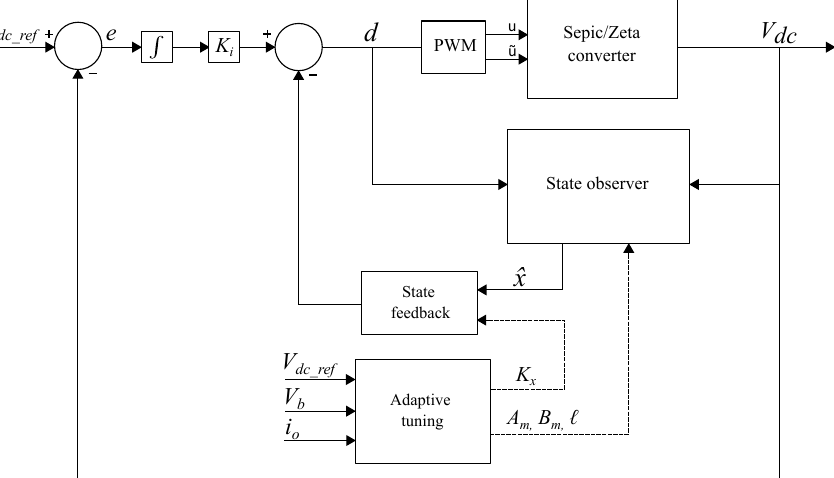
Figure 10. Structure of the adaptive LQI voltage controller.